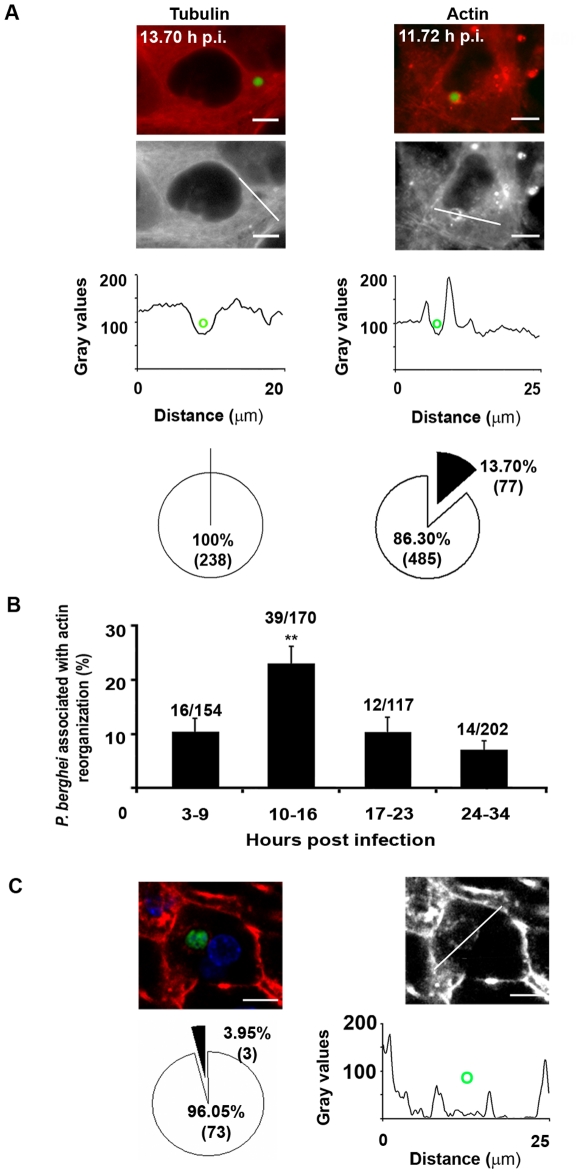
Hepatocyte cytoskeleton reorganization around developing P. berghei in vitro and in vivo.(A) Actin but not tubulin is reorganized in Huh7 cell lines infected with GFP-Pb parasites (red and grey: mCherry::α-tubulin or mCherry::β-actin; green: GFP-Pb). Plot profiles represent the pixel intensity (gray values) of the regions indicated in the pictures (lines); o represents the parasite. Pie plots represent the percentages and absolute numbers of parasites associated (▪) or not (□) with host cytoskeleton reorganization. (B) Distribution of the percentage of P. berghei parasites associated with host cell actin reorganization in different infection periods. Numbers of parasites associated with actin reorganization/total numbers of parasites analysed are indicated above the bars. (C) Hepatocyte F-actin around P. berghei EEFs at 24 hours p.i. in BALB/c mice livers (red and grey: Phalloidin AlexaFluor 594; green: GFP-Pb; blue: nuclei). The pie plot represents the percentage and absolute numbers of parasites associated (▪) or not (□) with host actin reorganization. Plot profile represents the pixel intensity (gray values) along the white line; o represents the parasite. Error bars represent Standard Errors ** p<0.01, scale bars represent 10 µm.